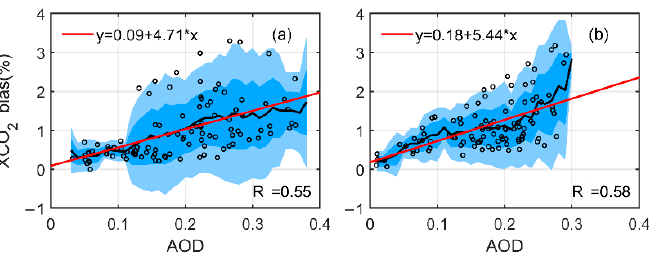
Figure 5. Correlation analysis between ∆ X CO 2 and τ 755 when τ 532 = 0: ( a ) JJA season at Bialystok site; ( b ) JJA season at Garmisch site. The blue shaded areas represent the standard error (1 σ and 2 σ ).